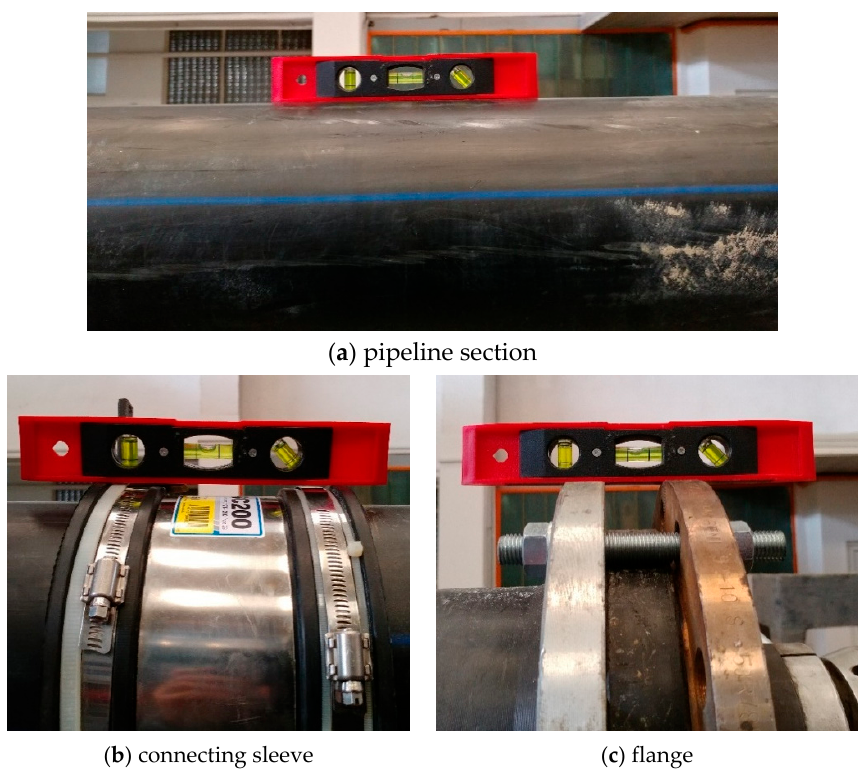
Figure 5. Horizontality of the system components.